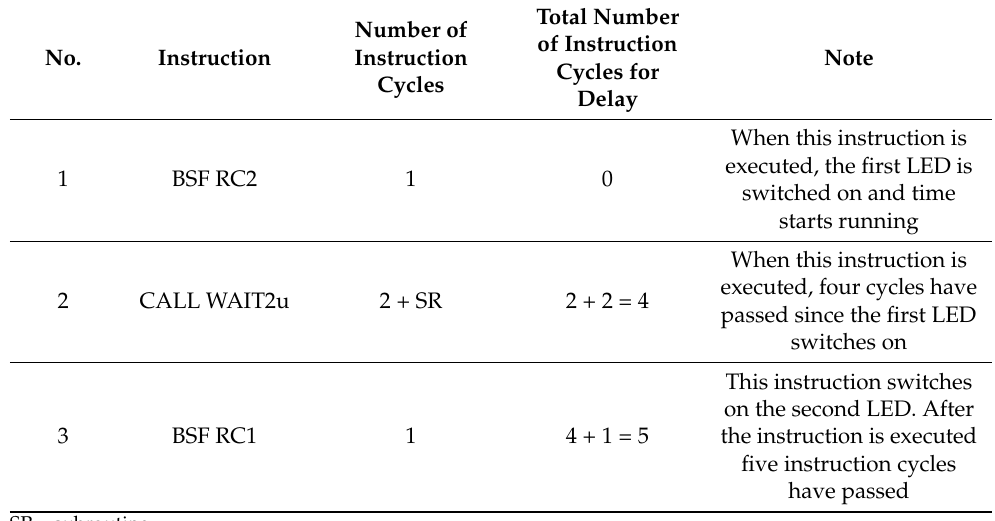
Table 1. The code and number of instruction cycles of subroutine for 2 µ s time delay.